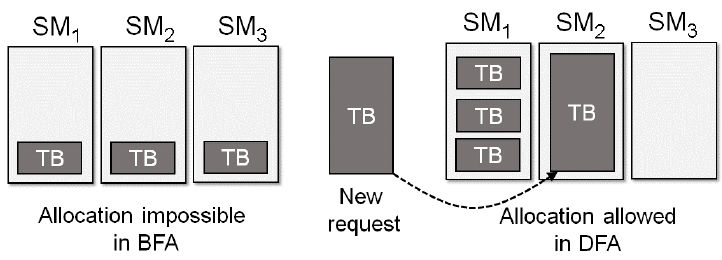
Figure 5. An example situation that can be accommodated by DFA, which is not possible in BFA.